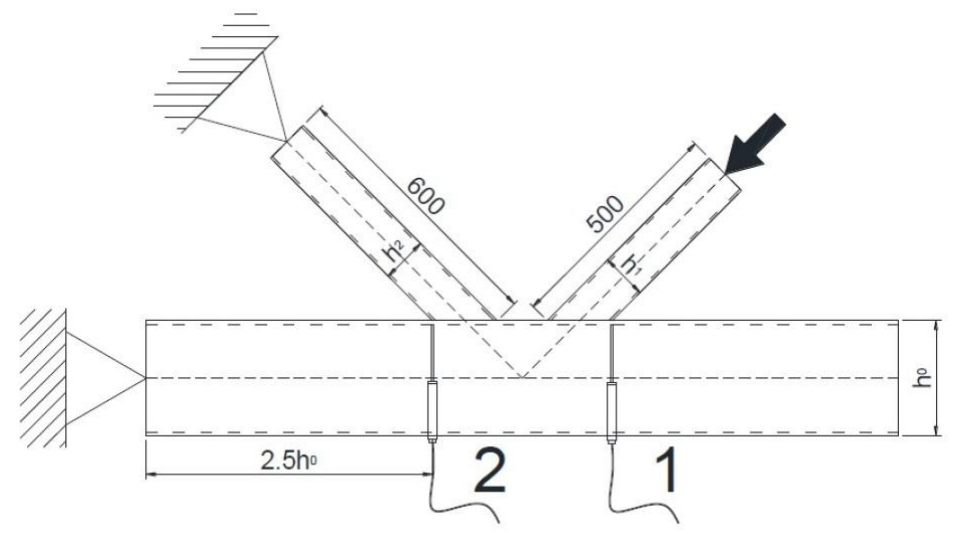
Figure 5. Tested K-joint configuration.